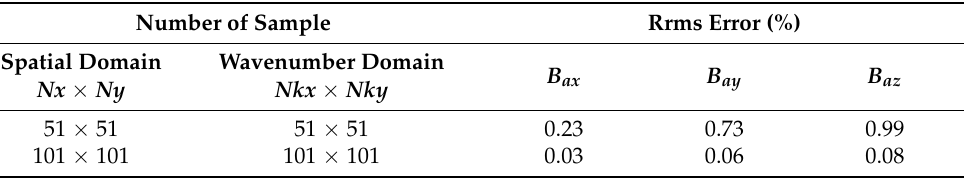
Figure 8. Magnetic field spectrum distribution in wavenumber domain (z = 3 km). Table 3. Accuracy statistics of different sampling points between − 1.55 × 10 − 3 –1.55 × 10 − 3 in the wavenumber domain (z = 0 m, Nz = 101, uniform sampling in both spatial and wavenumber domain).